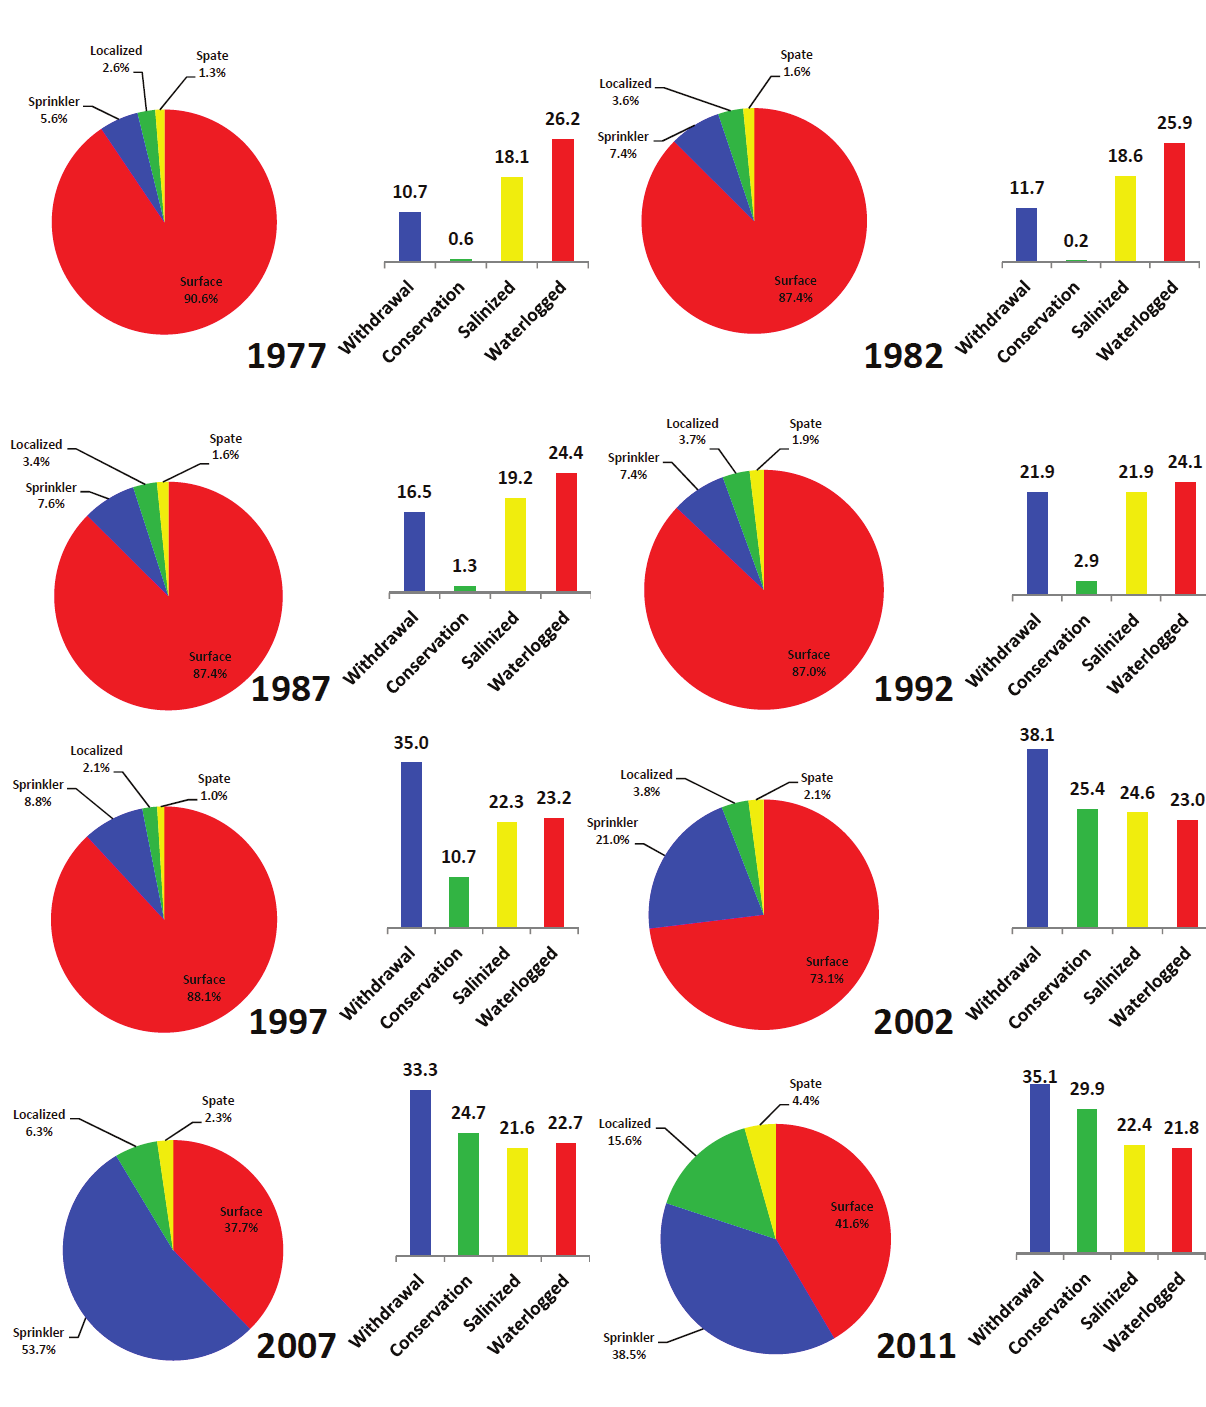
Figure 15: Variations of the sub main indexes of agricultural water management in Americas (value of the sub main indexes is not available before 1977), Surface indicates value of surface irrigation to total irrigation, Sprinkler indicates value of sprinkler irrigation to total irriga- tion, Localized indicates value of localized irrigation to total irrigation, Spate indicates value of spate irrigation to total irrigation, Withdra- wal indicates agricultural water withdrawal (10 km3/yr), Conservation indicates conservation agriculture area as percent of cultivated area (%), Salinized indicates percent of area equipped for irrigation salinized (%), Waterlogged indicates area waterlogged by irrigation